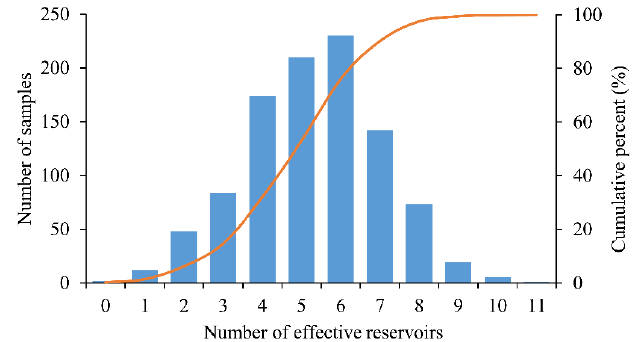
Figure 5. The number of effective reservoirs in random flood samples. Table 3. The complexity of POA and GA.